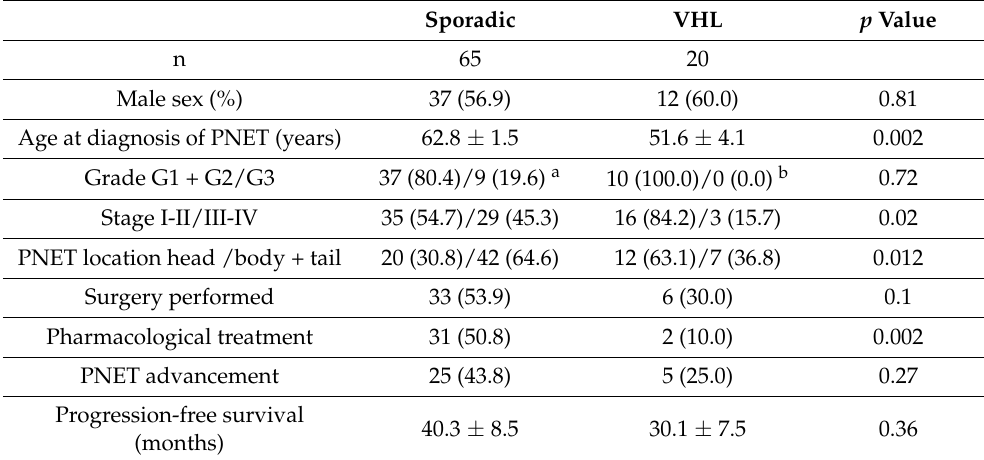
Table 2. Demographic and clinical comparison between VHL-related and sporadic PNET.